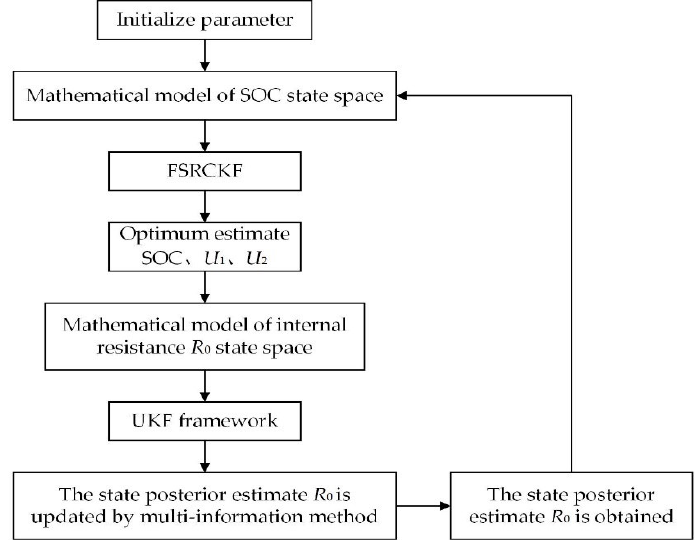
Figure 5. The schematic diagram of MIUKF-FSRCKF.